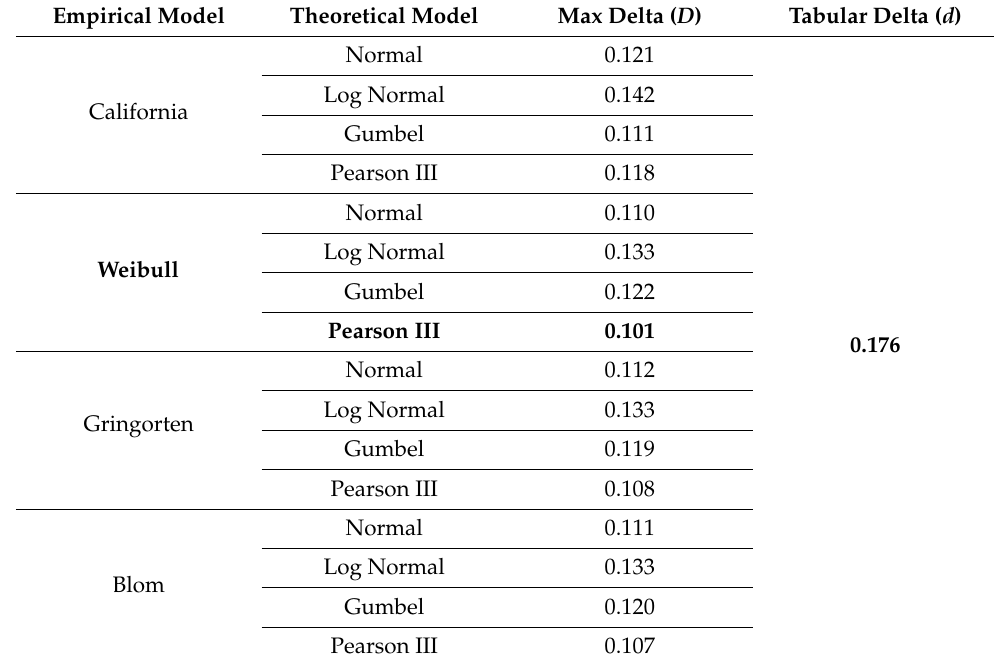
Table 1. Kolmogorov–Smirnov goodness of fit test combination results. Table 1. Kolmogorov – Smirnov goodness of fit test combination results.